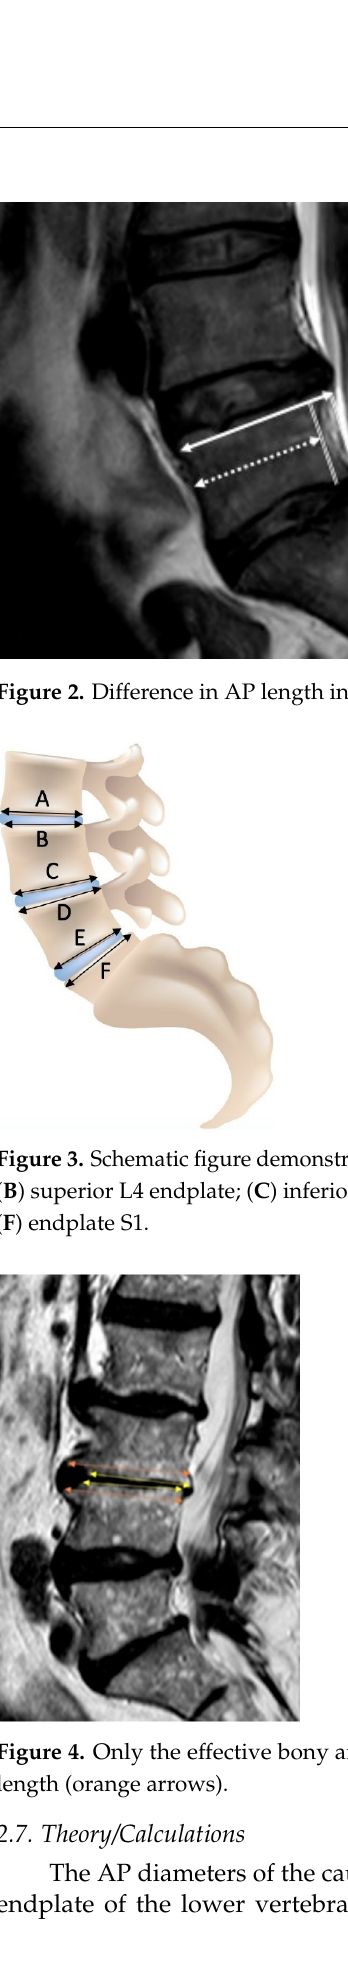
. Figure 4. Only the effective bony area (yellow arrows) was measured compared to the maximum length (orange arrows). 2.7. Theory/Calculations The AP diameters of the caudal endplate of the upper vertebral body and the cranial endplate of the lower vertebral body were used to determine whether disproportion ex- isted (the length of the caudal endplate minus the length of the cranial endplate from the consecutive vertebral body). In 2012, Niggemann et al. [27] reported the cutoff value for